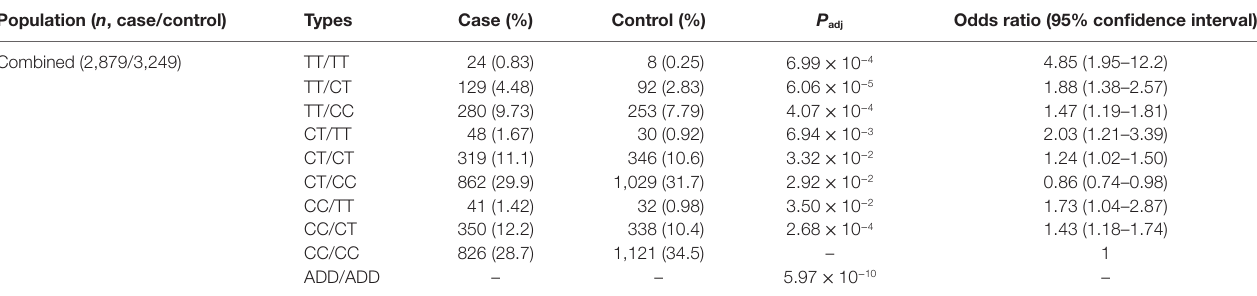
TaBle 3 | Interaction analysis between rs3806933 in thymic stromal lymphopoietin and rs6897932 in interleukin 7 receptor under the genotypic model in the combined population. Population ( n , case/control)